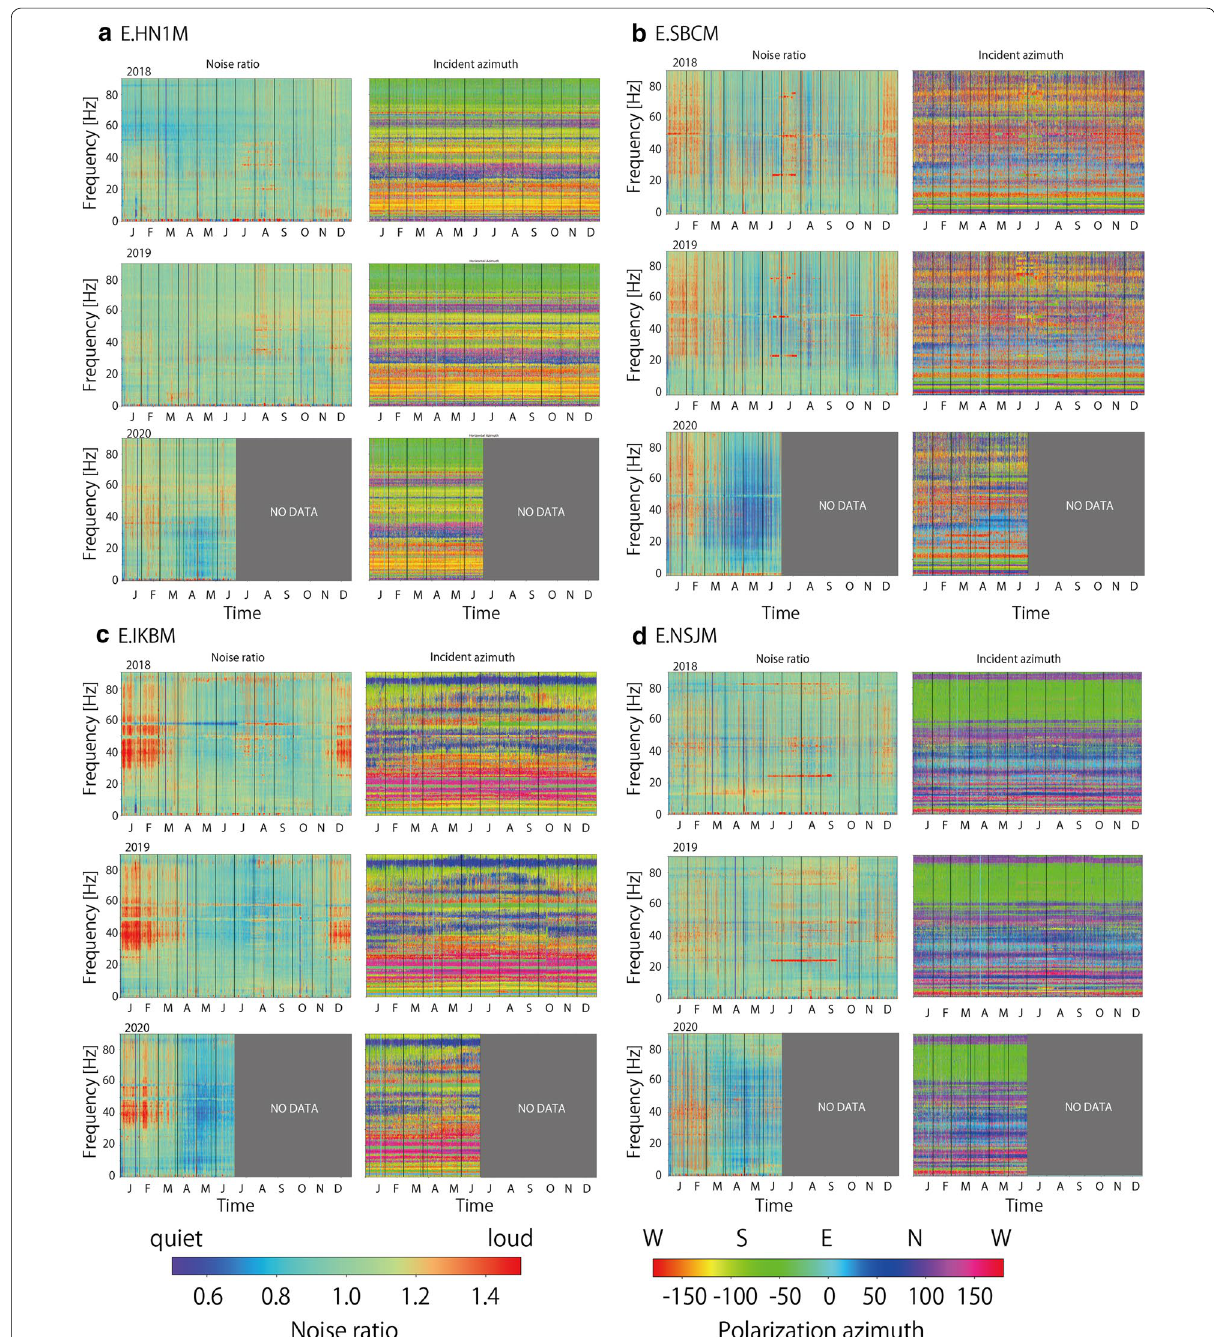
Fig. 7 Noise ratio of UD components and polarization azimuth at four stations. The cases of two-step ( a and b ) and one-step seismic noise reduction ( c and d